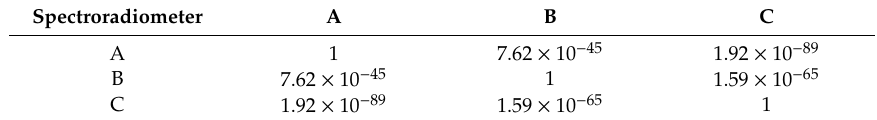
Table 3. ANOVA test ( p -value) of spectroradiometer data for study areas (age categories) A, B, C.